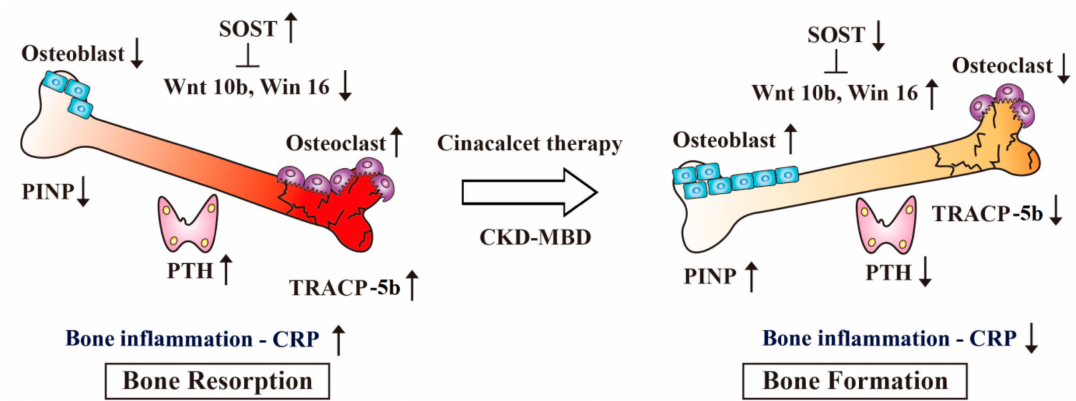
Figure 5. Potential mechanisms of therapeutic e ff ects of Cinacalcet on CKD-MBD. The schematic diagram illustrates that increased SOST expression in patients with secondary hyperparathyroidism inhibits Wnt 10b / Wnt 16 signaling pathway, leading to activating osteoclastic bone resorption (TRACP-5b) and inactivating osteoblastic bone formation (PINP), and ultimately bone inflammation and low bone density. Beyond iPTH suppression, Cinacalcet therapy intensifies bone density through inhibiting SOST expression and upregulating Wnt-10b / Wnt 16 signaling that activates osteoblastic bone formation (PINP) and inactivates osteoclastic bone resorption (TRACP-5b), along with the improvement of inflammatory milieu (CRP). CKD-MBD, chronic kidney disease and mineral bone disease; CRP, C-reactive protein; iPTH, intact parathyroid hormone; PINP, procollagen type I propeptides; SOST, sclerostin; TRACP-5b, tartrate-resistant acid phosphatase isoform 5b; Wnt, Wingless and int-1; ↑ , increase; ↓ ,